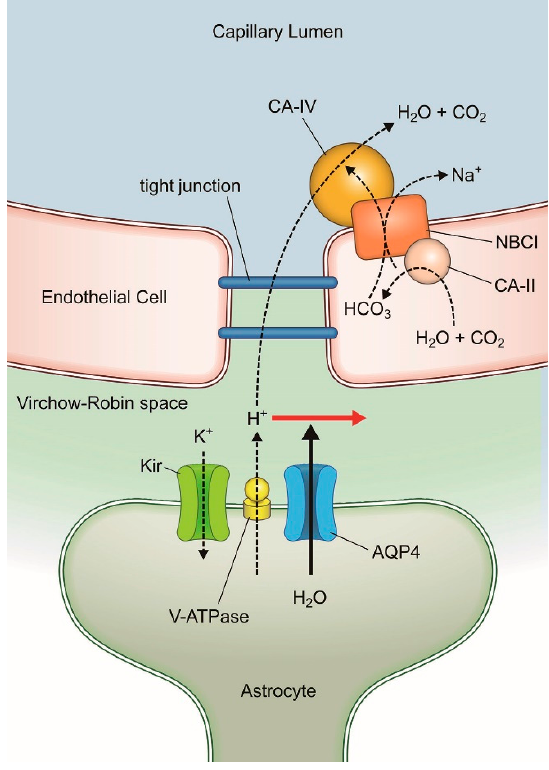
Figure 4. Molecular processes within the Virchow–Robin space associated with neural activation. Neural activation induces potassium efflux into the interstitial space which is quickly scavenged by inwardly rectifying potassium channel (Kir). This potassium spatial buffering promotes release of a counterpart cation, H + , by vacuolar ATPase, resulting in proton excess in the interstitial fluid (extracellular acidosis). AQP ‐ 4 is inhibited by higher proton density (red arrow). Excess protons move into the intracapillary space without significant resistance at the tight junctions because of the Grotthuss proton tunneling mechanism. Carbonic anhydrase type IV (CA ‐ IV) anchored to the luminal surface of capillaries and NBC1 sodium bicarbonate co ‐ transporter that interacts directly with CA ‐ IV effectively scavenge these excess protons. Modified from Reference [9].